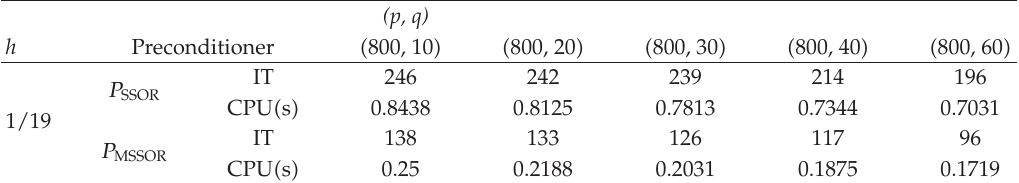
Table 1: Iteration numbers for the two-dimensional Helmholtz equations for h (cid:10) 1 / 19 meshes, using COCG with the preconditioner P SSOR and P MSSOR for solving the complex symmetric indefinite linear systems.